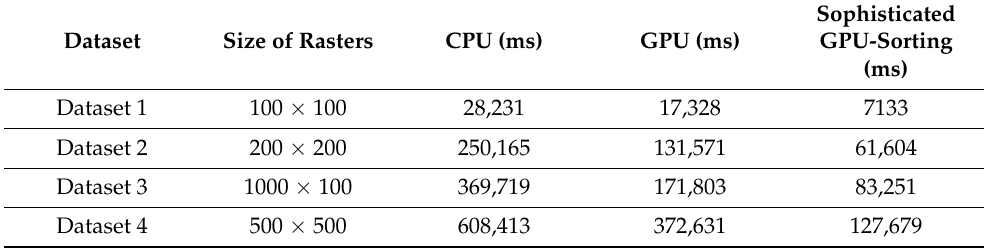
Table 5. Experiments on Air Humidity.